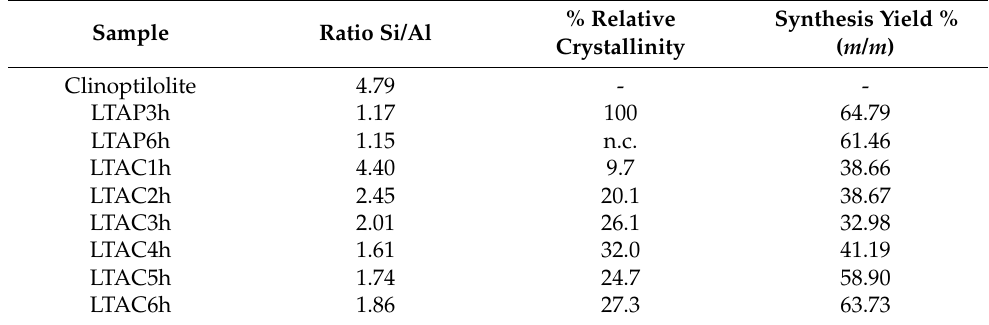
Table 4. Si/Al molar ratio values, relative crystallinity percentage, and synthesis yield of standard LTA zeolites and LTA zeolites from clinoptilolite. % Sample Ratio Si/Al